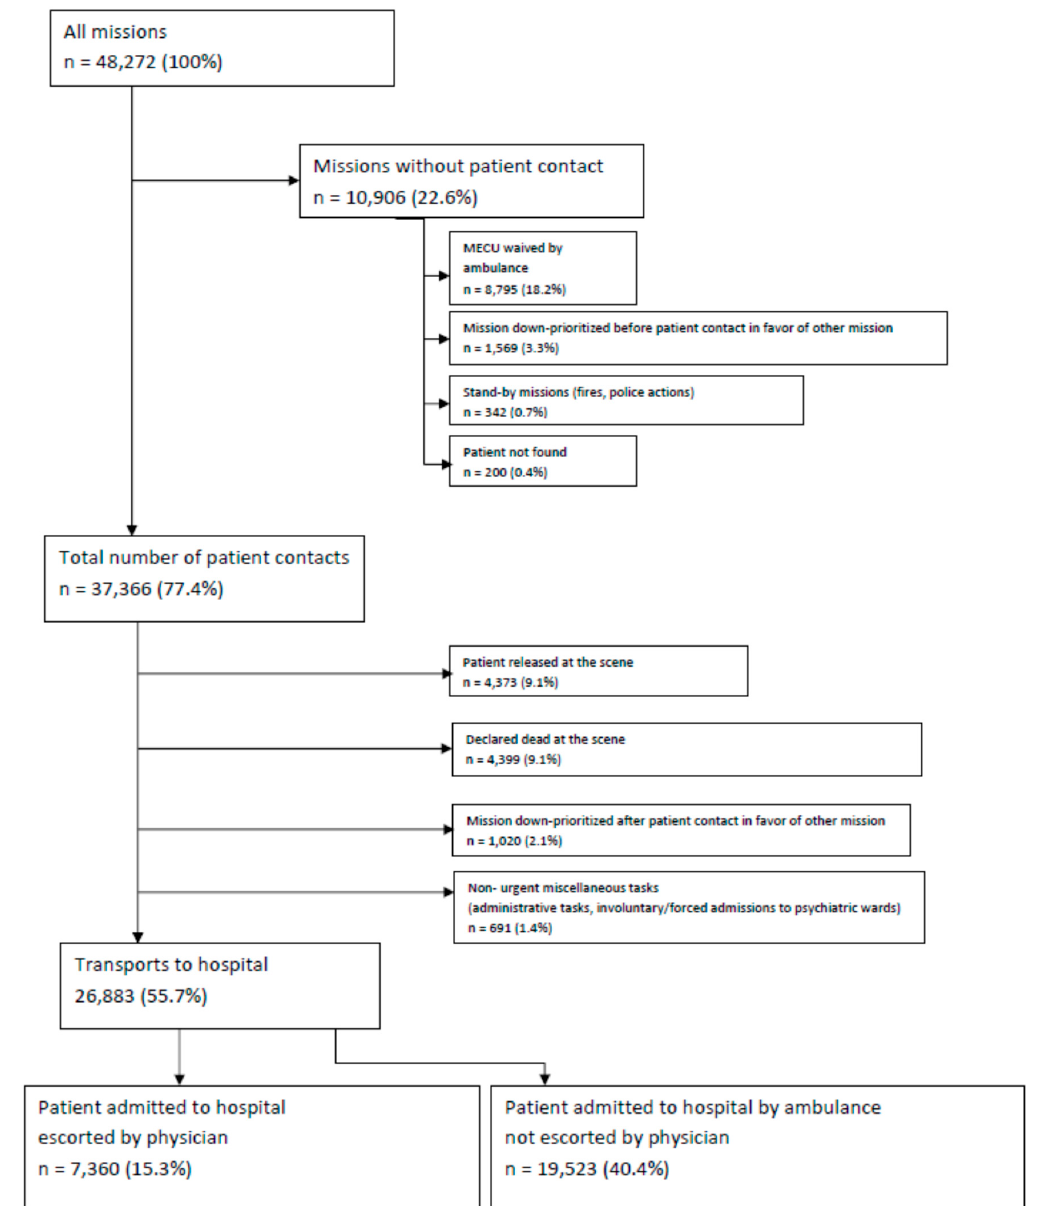
Figure 1. Flowchart depicting the distribution of mobile emergency care unit (MECU) missions in 2007–2018.